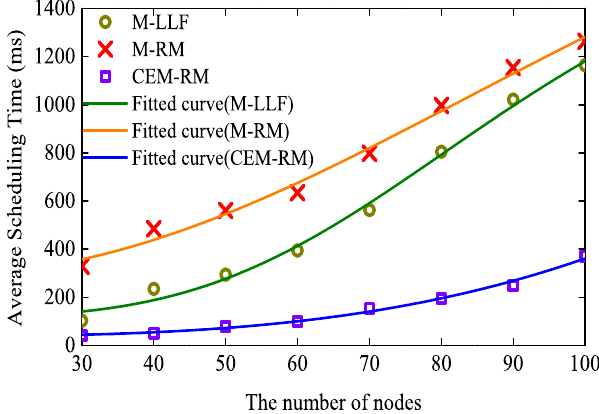
Figure 7. Comparison of scheduling time of the three algorithms.